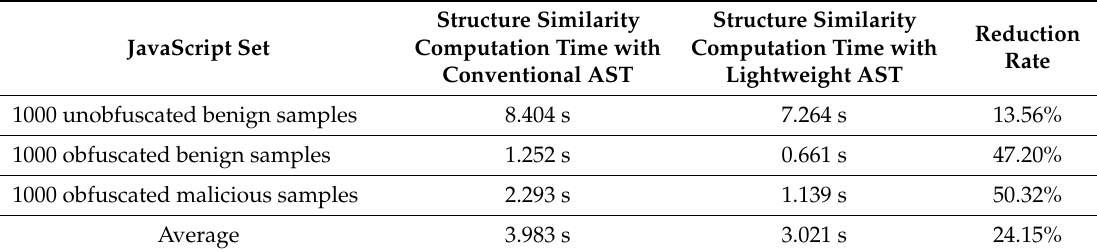
Table 5. Structure similarity computation time.